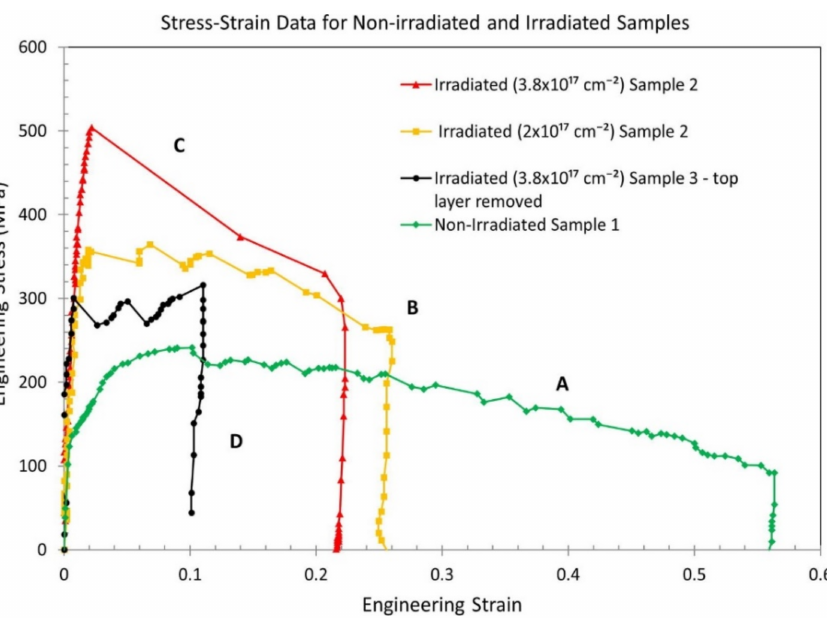
Figure 13. Engineering stress–strain data of one specimen from each irradiation condition [23]. To study the mechanical characteristics of thin nitride compound layers, micro- tensile smooth and notched specimens with dimensions of 77 µ m × 11.3 µ m × 5.3 µ m (length × width × thickness) fabricated by FIB were tested inside SEM by Arnaud et al. [75]. The in situ tensile experimentation combined with the DIC system was exploited to de- termine the elastic modulus, and the Poisson’s ratio of the tested thin surface layer. Addi- tionally, the FEA method for the micro-notched sample considering the notch radius